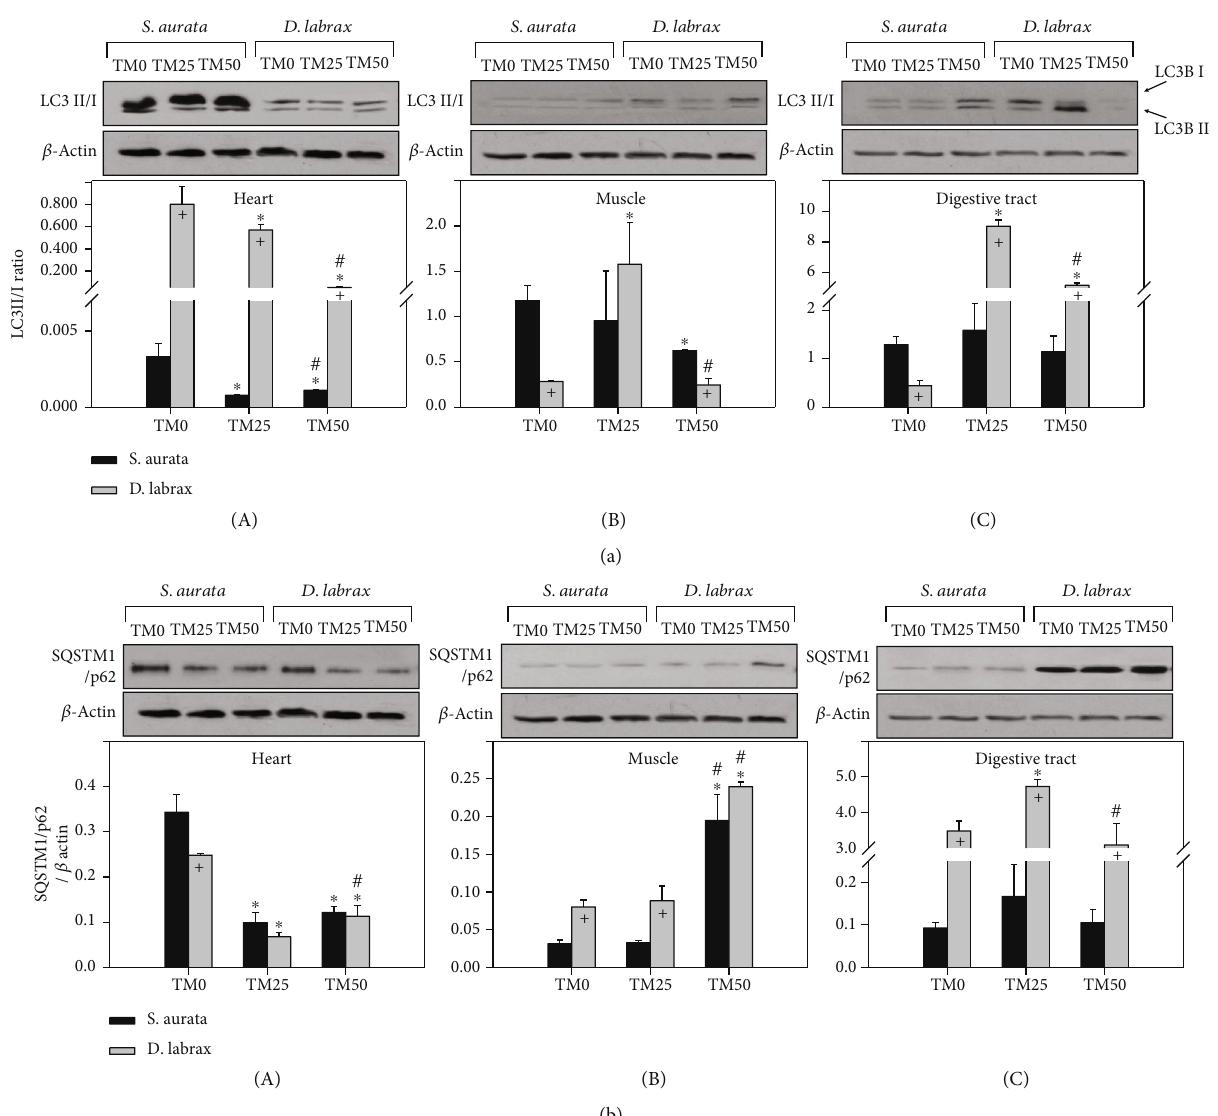
Figure 5: LC3BII/LC3BI ratio (a) and SQSTM1/p62 (b) in the heart (A), muscle (B), and digestive tract (C) of gilthead sea bream ( S. aurata ) and European sea bass ( D. labrax ) under the 0% (TM0), 25% (TM25), and 50% (TM50) T. molitor inclusion diet treatment. Representative immunoblots are shown and were quanti fi ed by laser scanning densitometry and plotted. Values represent means ± SD ; n = 5 preparations from di ff erent animals. ∗ indicates p < 0 : 05 compared with 0%, # indicates p < 0 : 05 compared with 25%, and + indicates p < 0 : 05 between species at the same TM